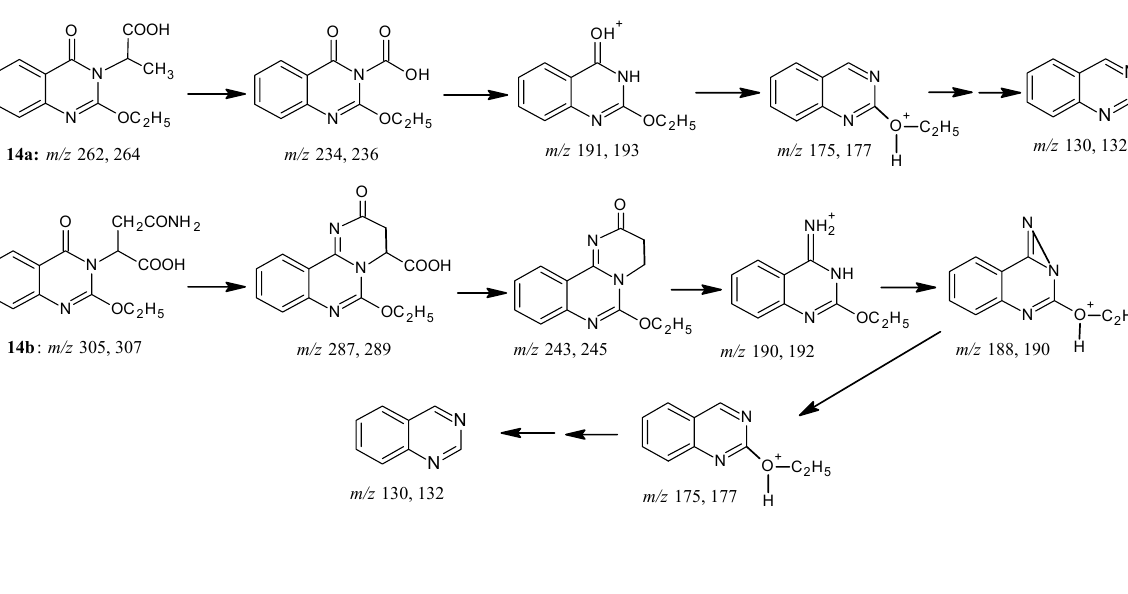
Scheme 20. Mass spectra interpretation for compounds 14 and 15